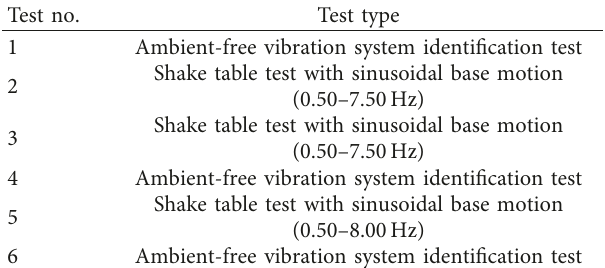
Figure 10: Acceleration recorded at the base during Test Run-3. Table 4: Sequence of test.